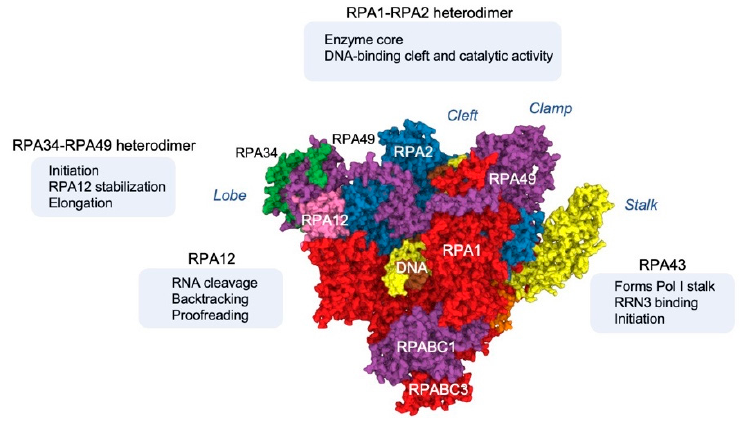
Figure 2. Human Pol I complex subunits. Key elements of the human elongating Pol I complex subunits according to ref. [51]. The complex is rendered from Protein Data Bank structure, PDB:7OB9.